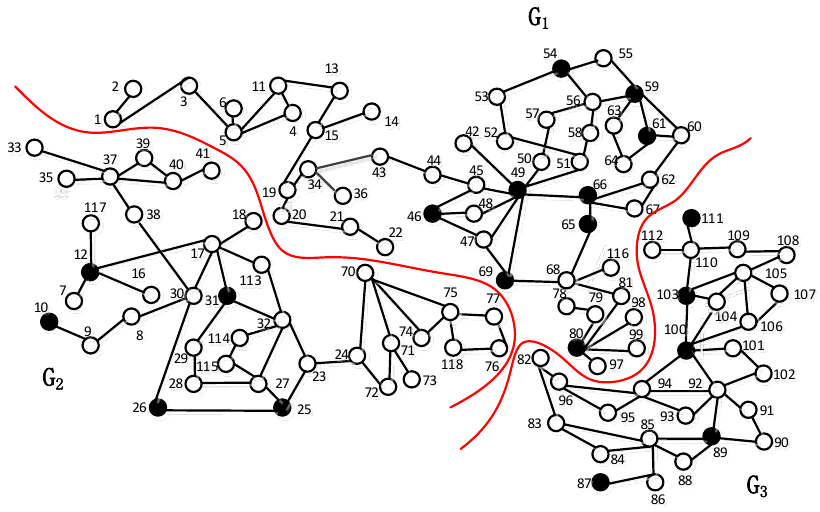
Figure 16. The pictorial result of instance ieee118-3-b generated by the algorithm with L = 7 .